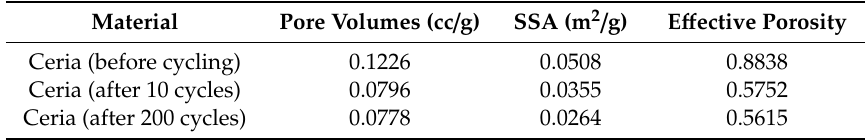
Table 3. Total pore volumes, specific surface area and e ff ective porosity of ceria before cycling, after 10 cycles and after 200 cycles from MIP analysis at low pressure